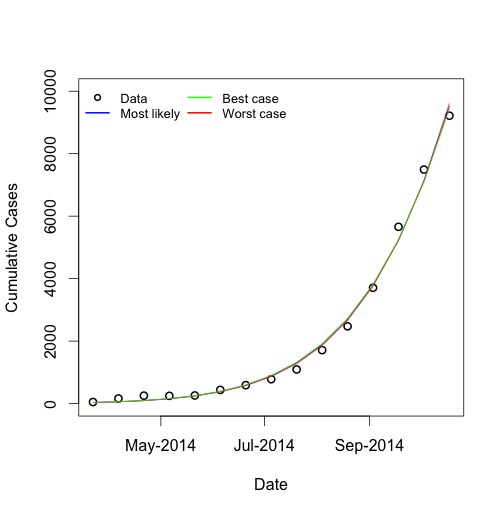
Model fits to cumulative Ebola virus case counts reported by World Health Organization, to October 18, 2014. Circles represent data, curves represent model fits for best-fit parameters, and for upper and lower bound parameters. Note that curves for most likely, best case, and worst case analyses display almost identical fits to data, but long term projections differ as below.